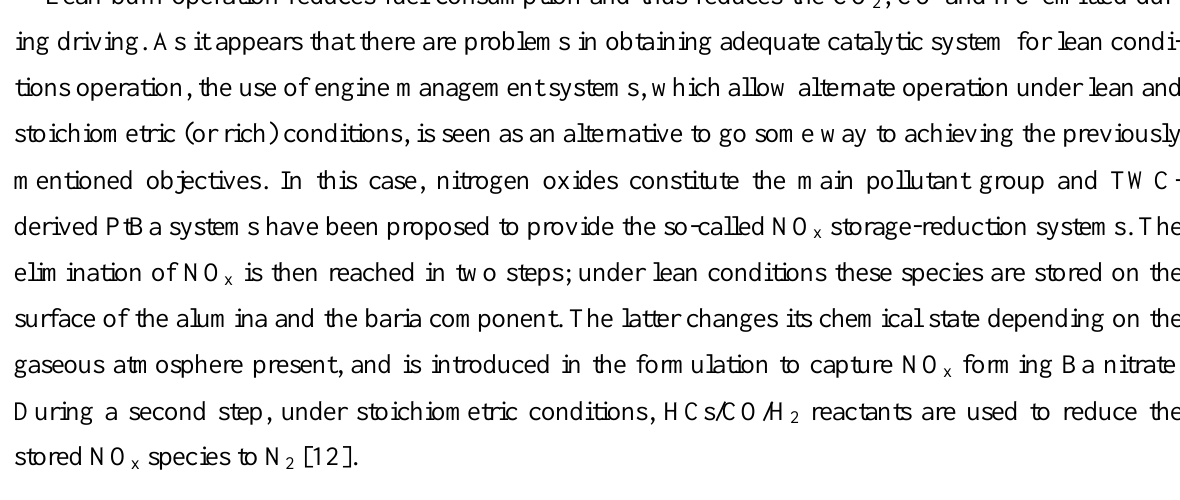
Fig. 7 In-situ DRIFTS difference spectra (i.e. the initial spectrum in O O systems recorded at 723 K in a) 0.16 % C Ag/Al 2 3 0.16 % NO to the reactant